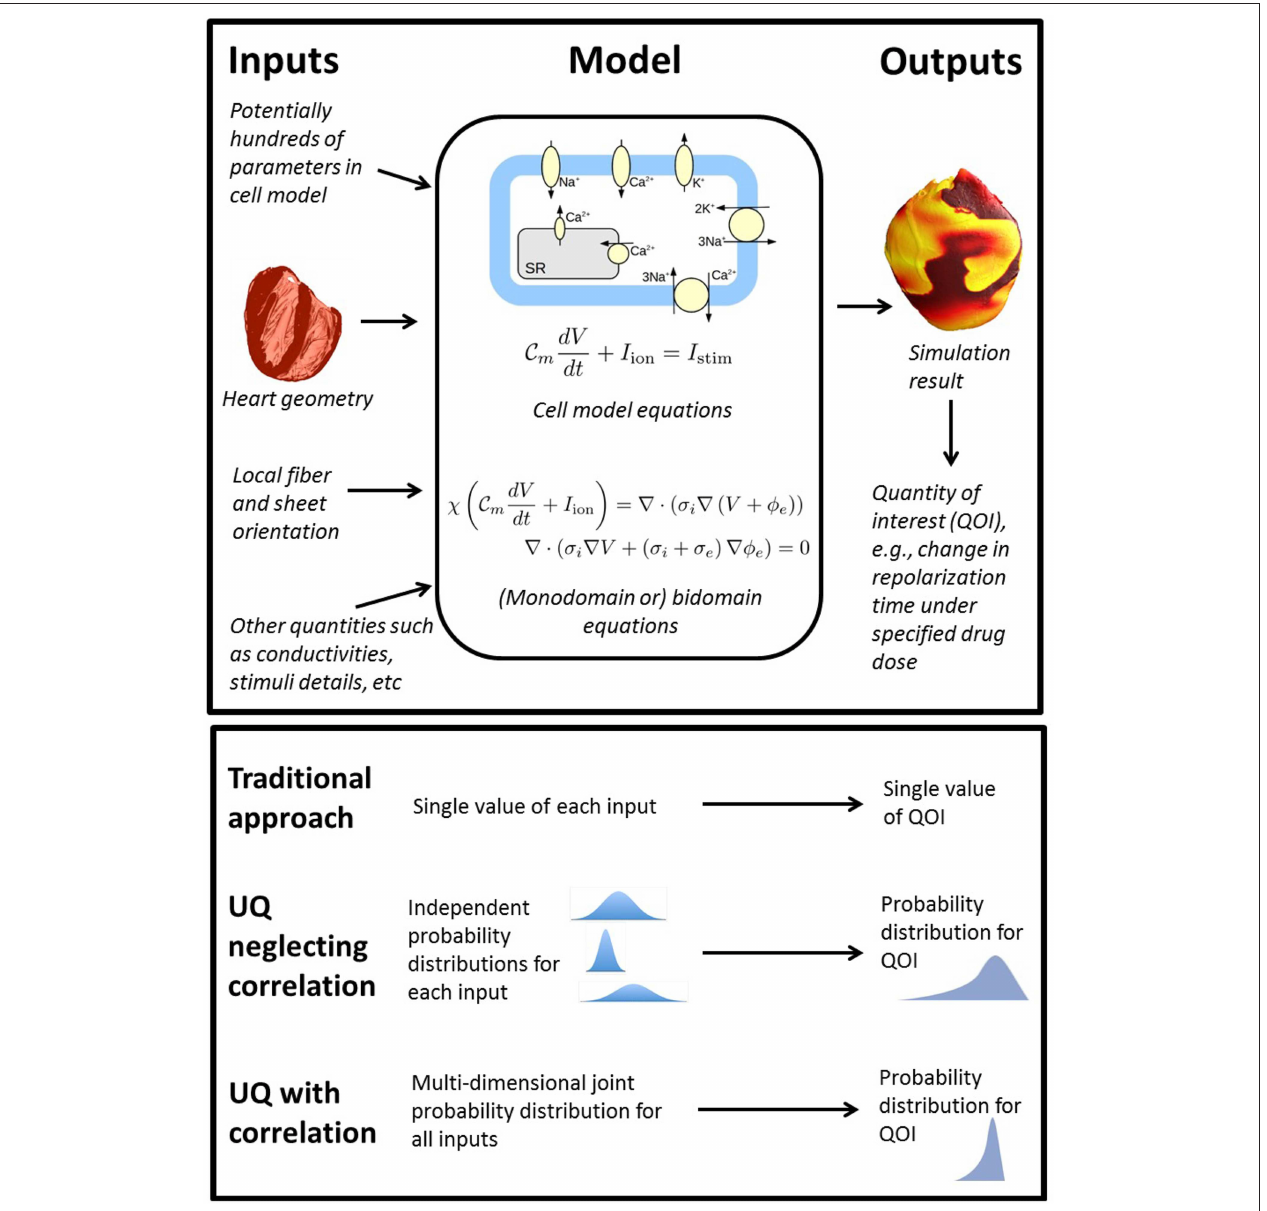
FIGURE 1 | Top : overview of the wide range of inputs (quantities derived from experimental data) in whole heart models, all of which are uncertain to some extent, together with model equations and sample output. Bottom : comparison of traditional approach (no UQ), UQ neglecting potential correlations between model inputs, and UQ accounting for